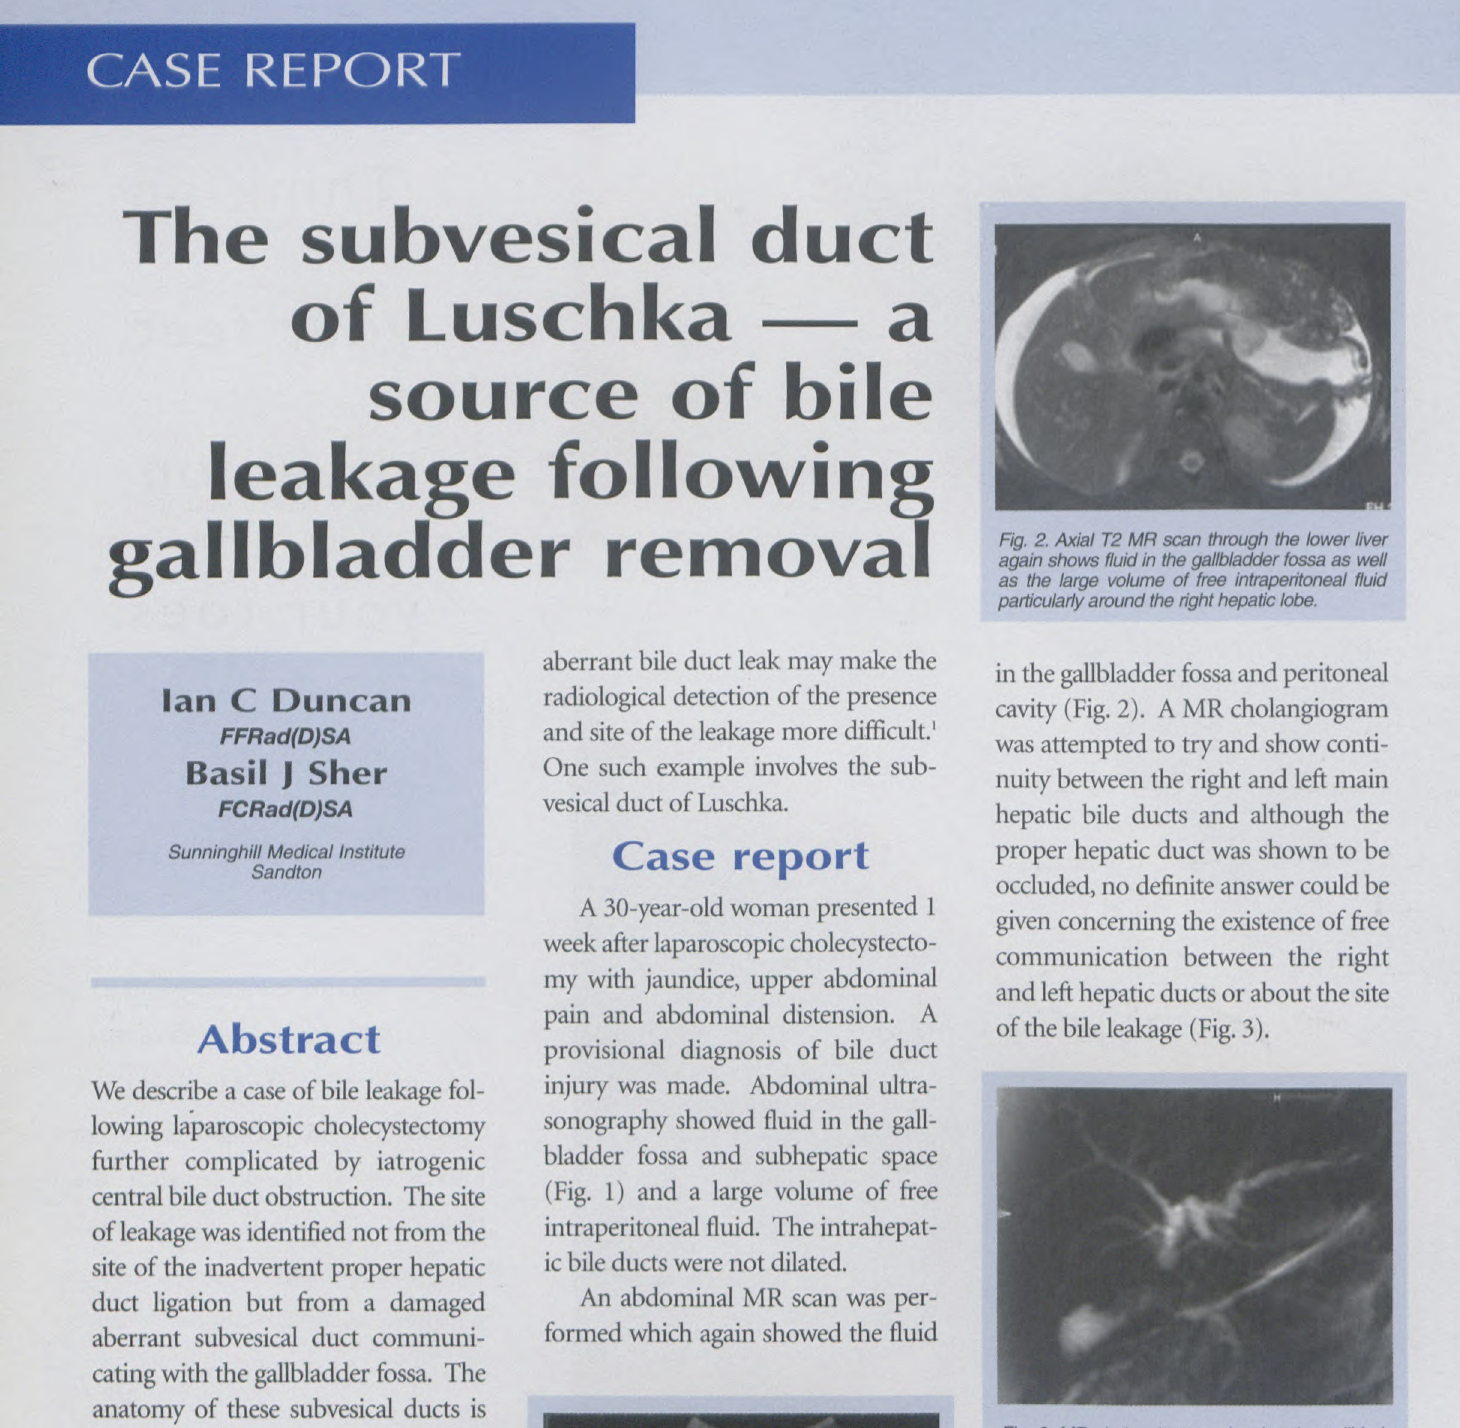
Fig. 3. MR cholangiogram showing the gal/blad- der fossa and free fluid in the subhepatic space. Although the intrahepatic ducts are seen, continu- ity between the hepatic ducts across the conflu- ence cannot be